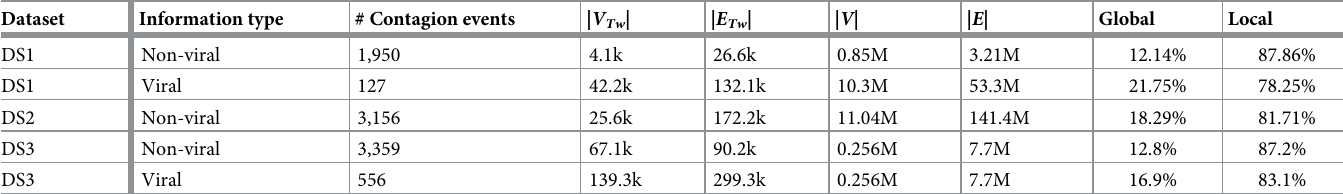
Table 2. A summary of the analyzed